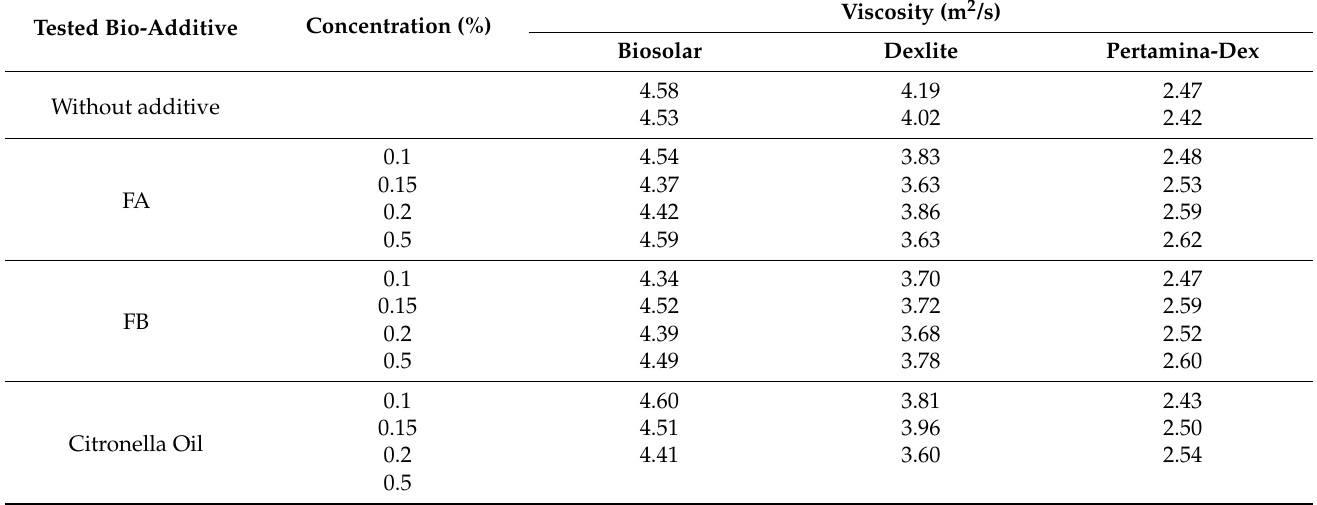
Table 9. Viscosity of fuel-bio additive